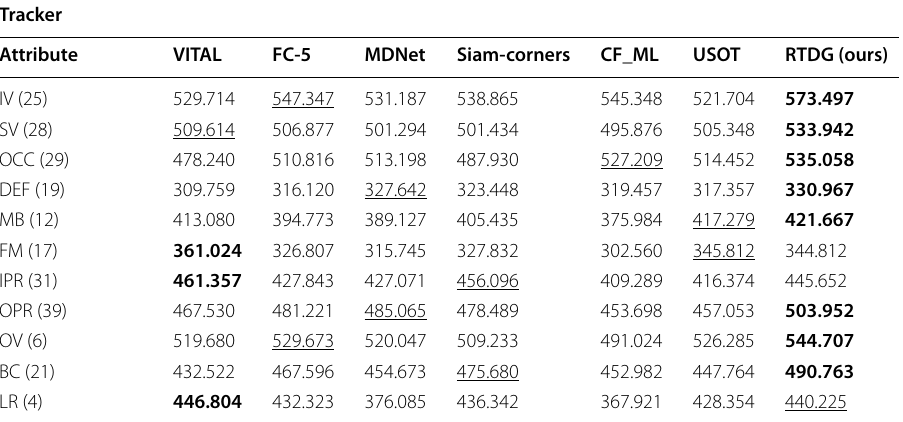
Table 2 The success scores of the state‑of‑the‑art trackers with different appearnce variations in OTB‑100